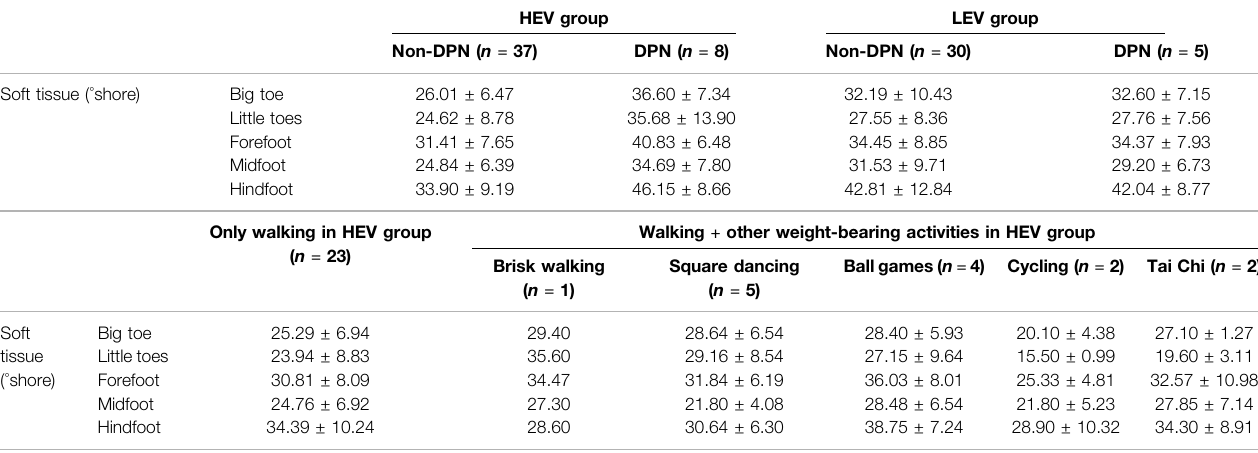
TABLE 3| Plantarsoft tissue hardness for Non-DPNand DPN participants in the HEV and LEV groups, and forNon-DPN participants performing different physical activities in the HEV group (Participants in LEV group did not engage in any form of exercise other than walking; Mean ±